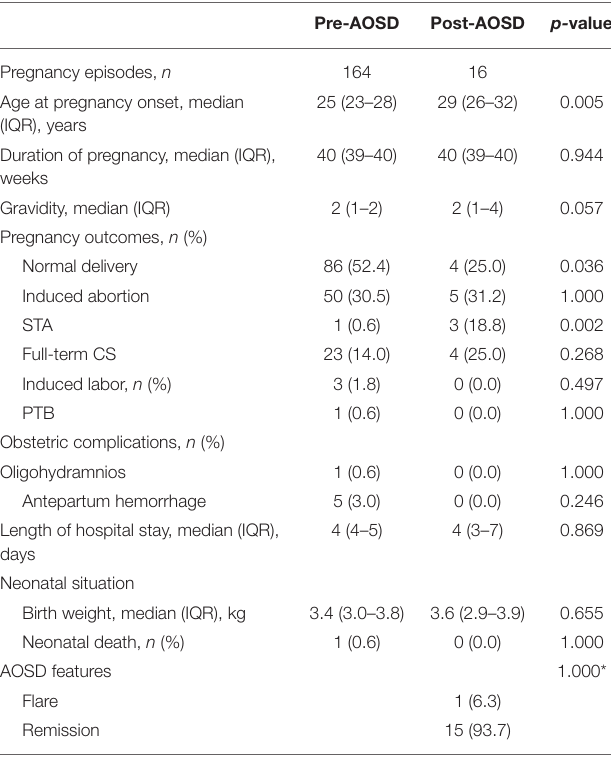
TABLE 2 | Maternal characteristics of pregnancies in women that occurred before and after AOSD diagnosis.